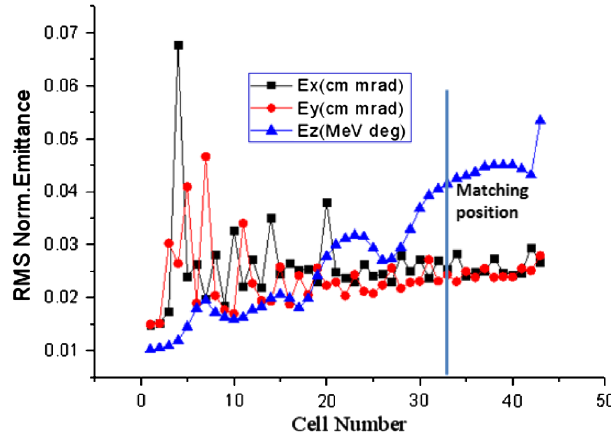
FIG. 3. Emittance variations along the RFQ cell number.